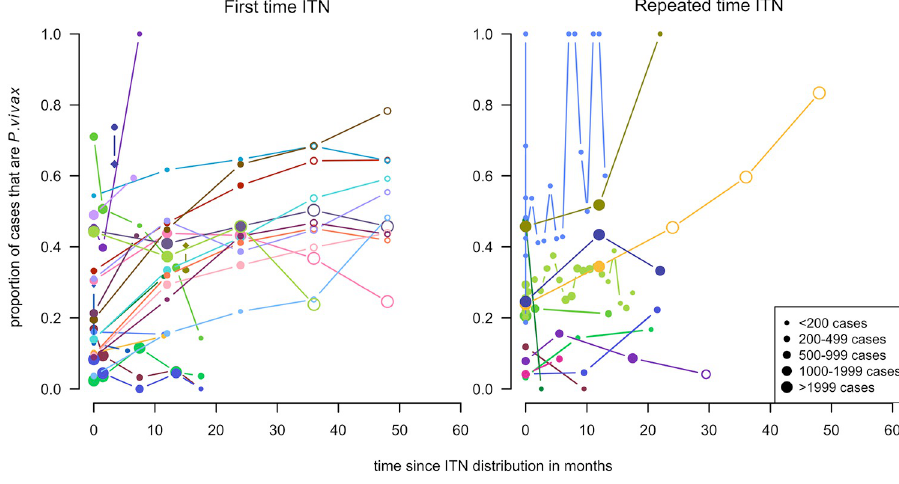
Fig 11. Spaghetti plots splitting the series of time-points of the proportion of cases with P. vivax infection by round of ITN distribution. Excluding series of time points that have no measurement within 24 months after the intervention. Dot size depending on number of